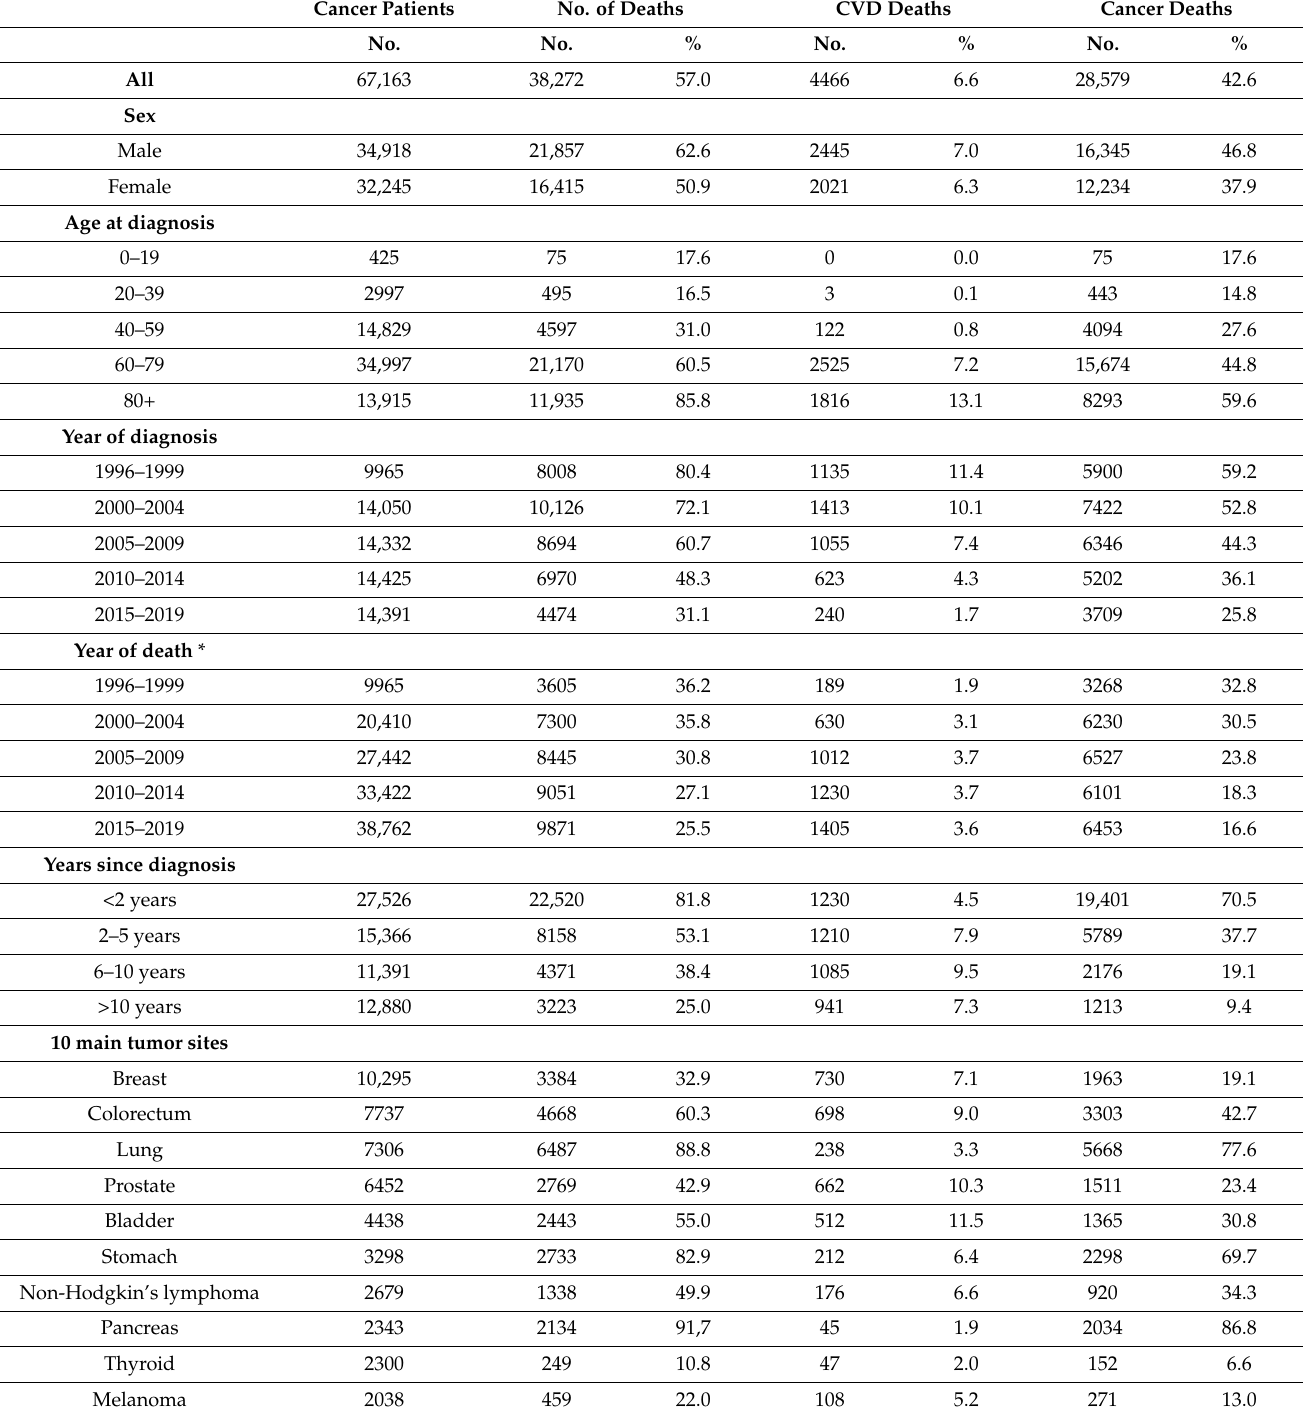
Table 1. Cancer patient incidence in Province of Reggio Emilia in the period of 1996–2019. Number and percentage of deaths, cardiovascular deaths, and cancer deaths, out of the total number of cancer patients. Cancer